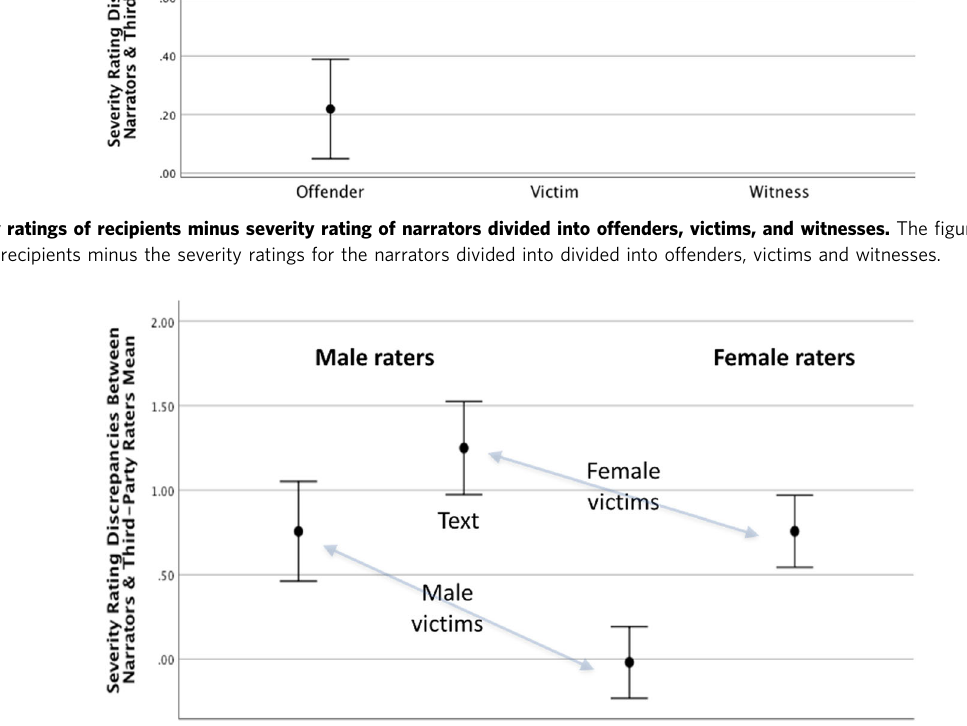
Fig. 7 Severity ratings of the recipients minus severity ratings of narrators divided into genders of raters and victims. The fi gure shows the severity ratings of the recipients minus severity ratings of narrators divided into genders of raters and victims.